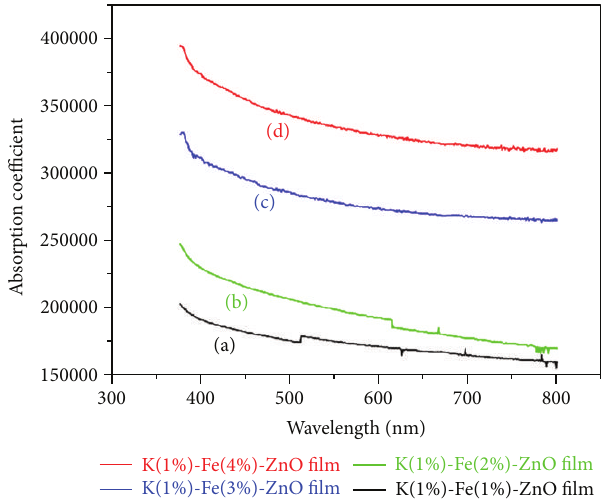
Figure 9: Absorption coefficient of (K (1%), Fe) codoped ZnO for Fe concentrations: (a) 1%, (b) 2%, (c) 3%, and (d) 4%.